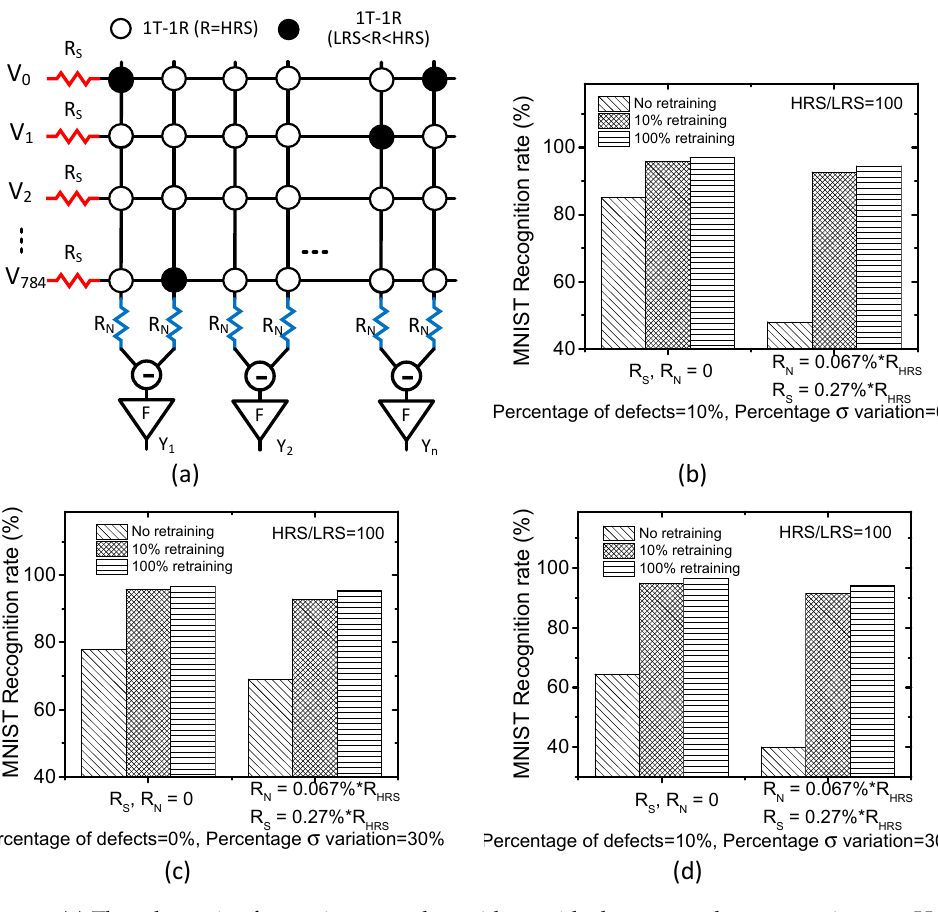
Figure 6. ( a ) The schematic of memristor crossbar with non-ideal source and neuron resistance. Here R S and R N represent source resistance and neuron resistance, respectively. ( b ) The MNIST recognition rates of the ideal (R N = R S = 0) and non-ideal (R N = 0.067% of R HRS , R S = 0.27% of R HRS ) crossbars for the percentage of stuck defects = 10% and the percentage σ variation in weights = 0% ( c ) the MNIST recognition rates of the ideal (R N = R S = 0) and non-ideal (R N = 0.067% of R HRS , R S = 0.27% of R HRS ) crossbars for the percentage of stuck defects = 0% and the percentage σ variation in weights = 30% ( d ) the MNIST recognition rates of the ideal (R N = R S = 0) and non-ideal (R N = 0.067% of R HRS , R S = 0.27% of R HRS ) crossbars considering both the percentage of stuck defects = 10% and the percentage σ variation in weights = 30%.